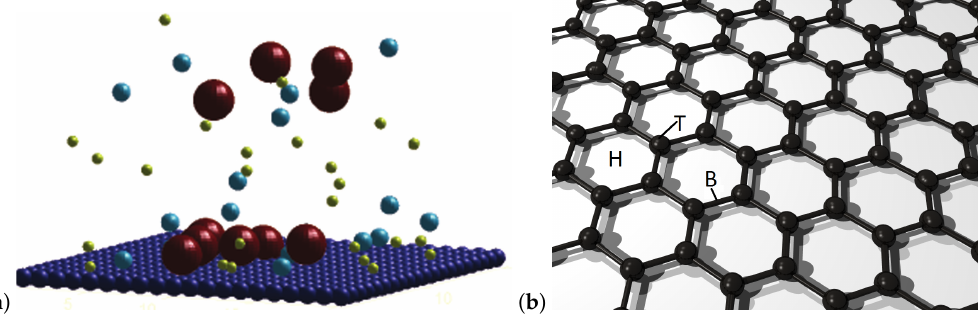
( a ) ADmoND-generated picture of a crystal surface surrounded by a mixture of three monatomic gases moving freely, adsorbing and desorbing in a stochastic manner. ( b ) Graphene